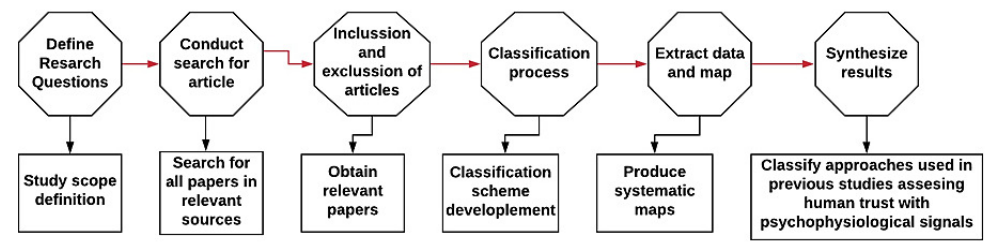
Figure 2. The systematic mapping study process adopted from [41] as adopted from [42–44].